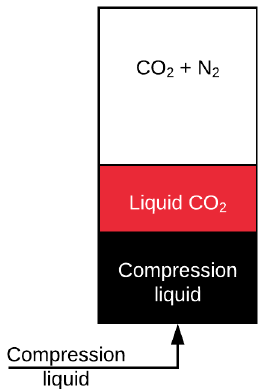
Figure 4. Schematic of the modeled system.